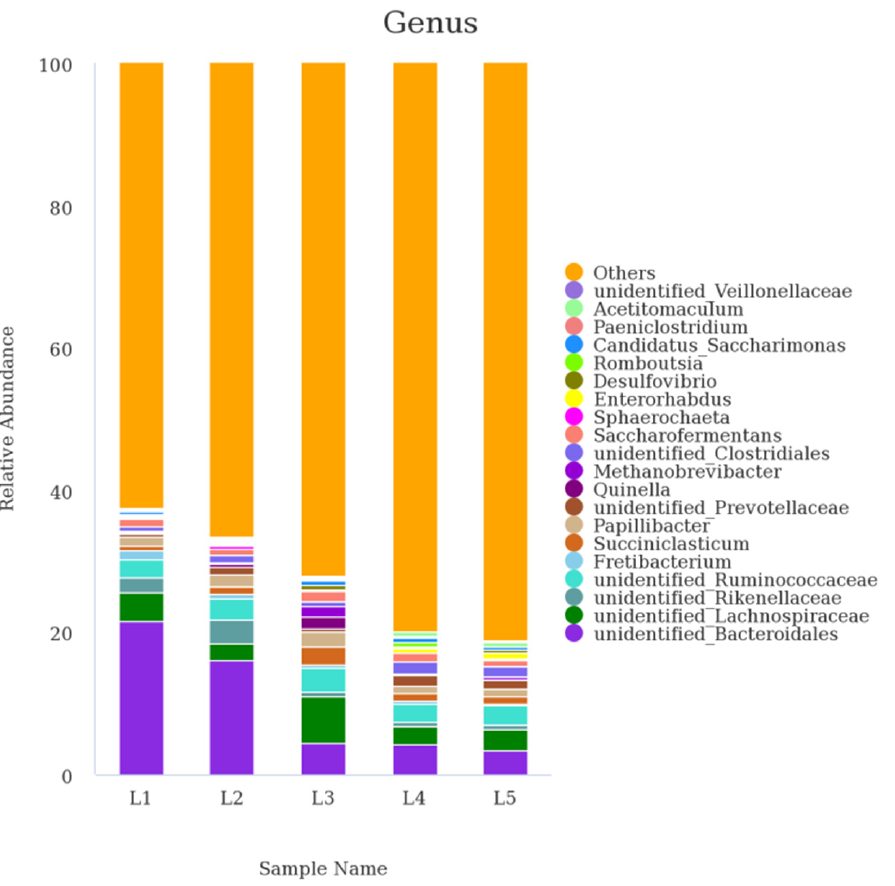
Figure 3. The column chart of the main dominant genus (only the top 20 abundant genera are presented). L1, L2, L3, L4, and L5 represent five groups of lambs treated with dietary alfalfa (AF) ratio at 0%, 20%, 40%, 60%, and 80% in the alfalfa–sweet sorghum (AF–SS) silage mixtures; n = 3 for each group.